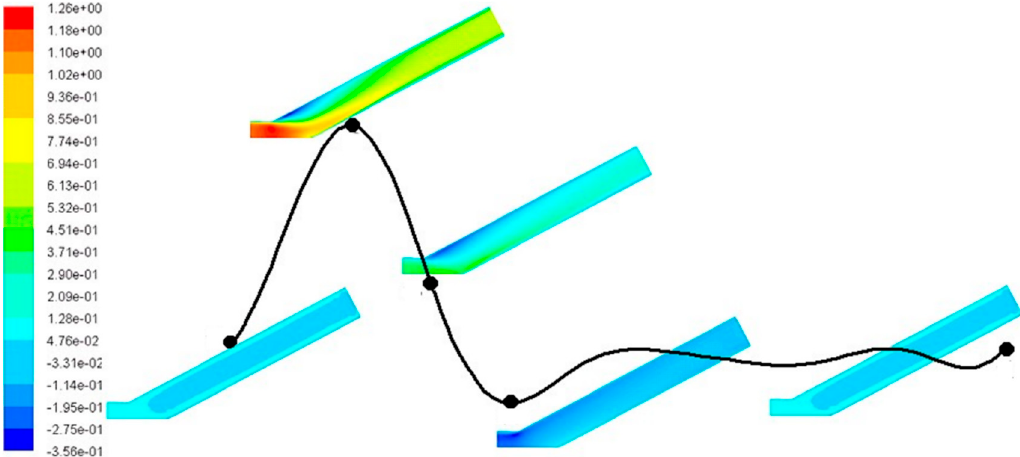
Figure 6. Distribution of X velocity (m/s) along the cardiac